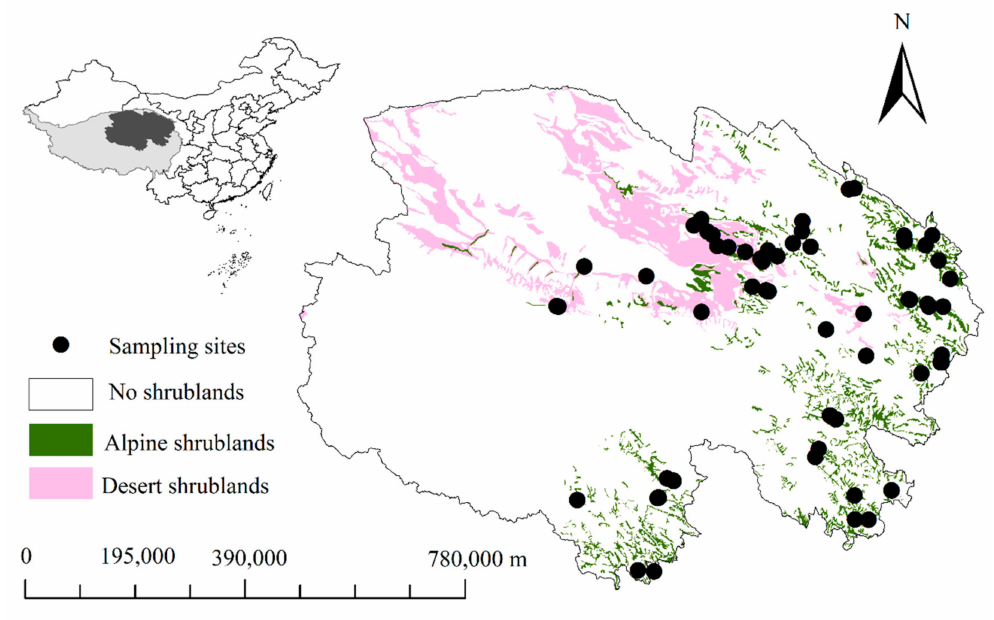
Figure 1. Distribution of 65 sampling sites in the shrublands of the Tibetan Plateau, which was based on the vegetation of China (1:100 0000)